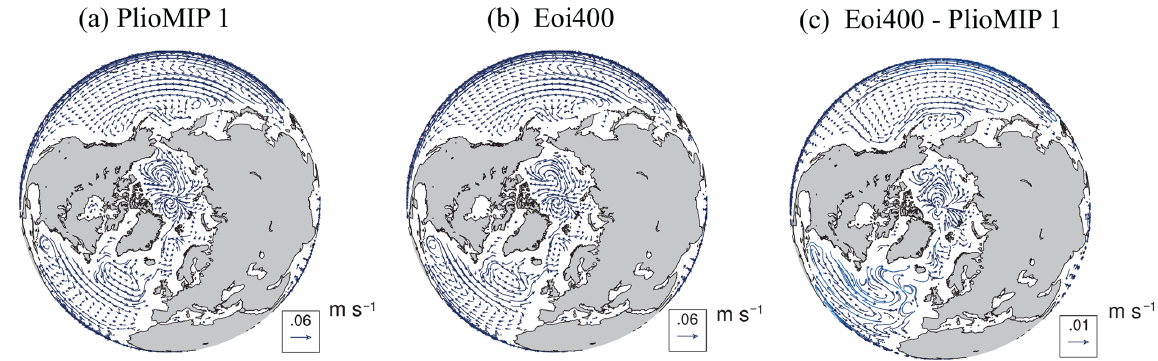
Figure 3. Mean annual ocean current above 500m for PlioMIP 1 (a) and Eoi400 (b) ; (c) shows the difference in ocean current between Eoi400 and PlioMIP1.